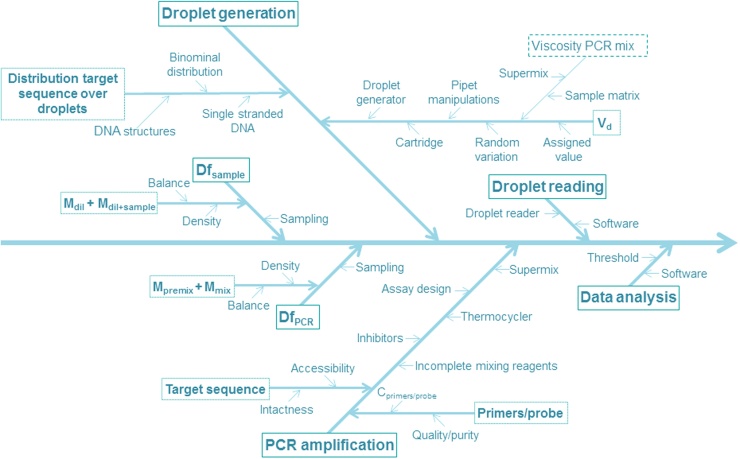
A schematic overview of all factors which may contribute to the uncertainty of the measurement results obtained with BCR-ABL ddPCR method as performed in this validation study.Cprimers/probe: concentration primers and probe, Dfsample: dilution factor of sample before addition to PCR mix, DfPCR: dilution factor of sample in the PCR mix, Mdil: mass of diluent, Mdil+sample: mass of diluent and sample, Mpremix: mass of pre sample mix, Mmix: mass of the PCR mix with sample, Vd: volume of the droplets